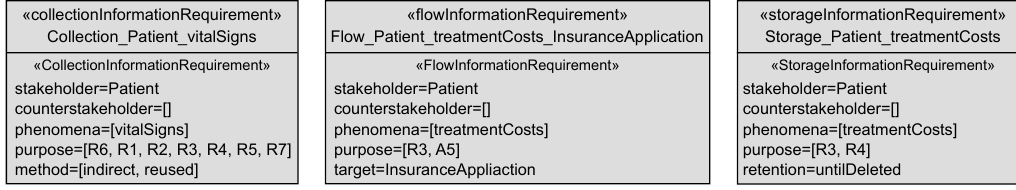
Figure 14. Examples of generated transparency requirements for the EHS